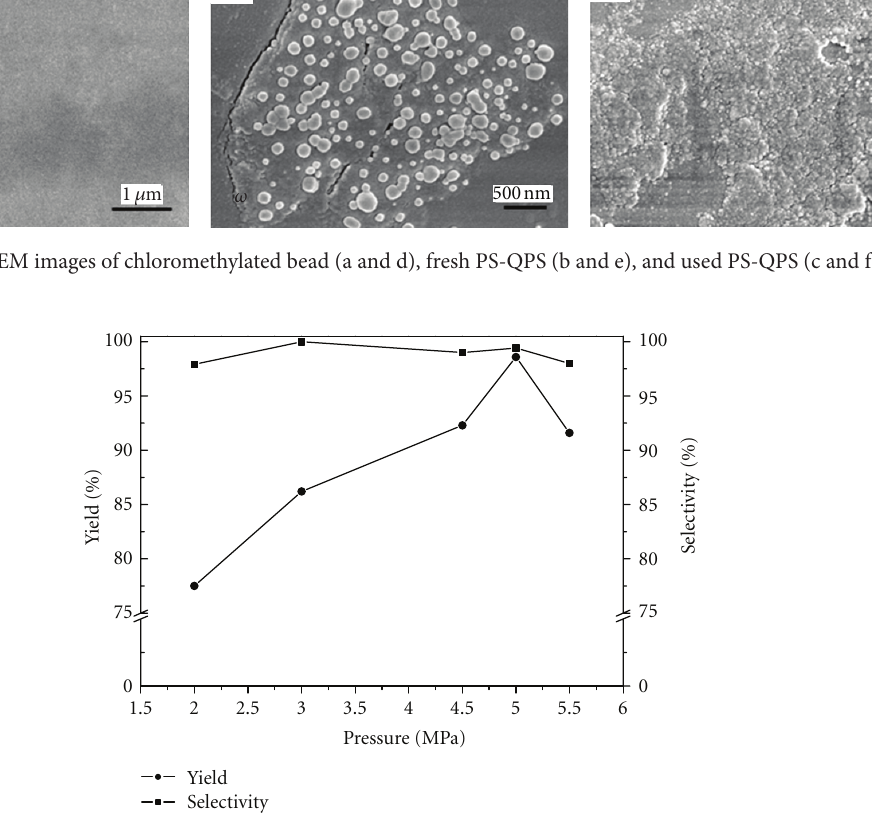
F 4: Dependence of the cyclic carbonate yield and selectivity on CO